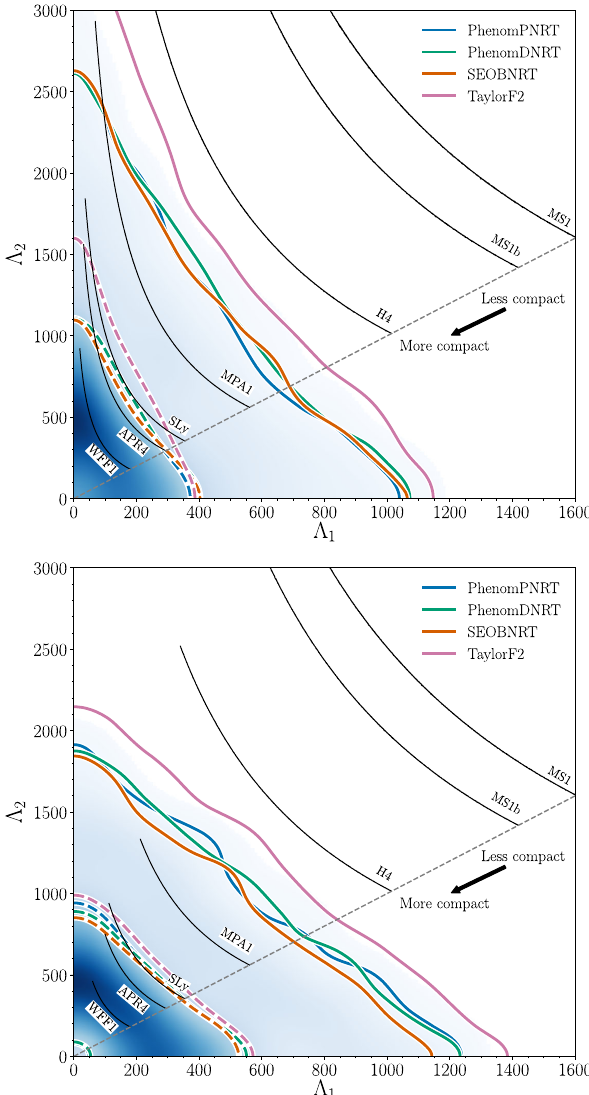
FIG. 10. PDFs for the tidal deformability parameters Λ 1 and Λ 2 using the high-spin (top panel) and low-spin (bottom panel) priors. The blue shading is the PDF for the precessing waveform PhenomPNRT. The 50% (dashed lines) and 90% (solid lines) credible regions are shown for the four waveform models. The seven black curves are the tidal parameters for the seven representative EOS models using the masses estimated with the PhenomPNRT model, ending at the Λ 1 ¼ Λ 2